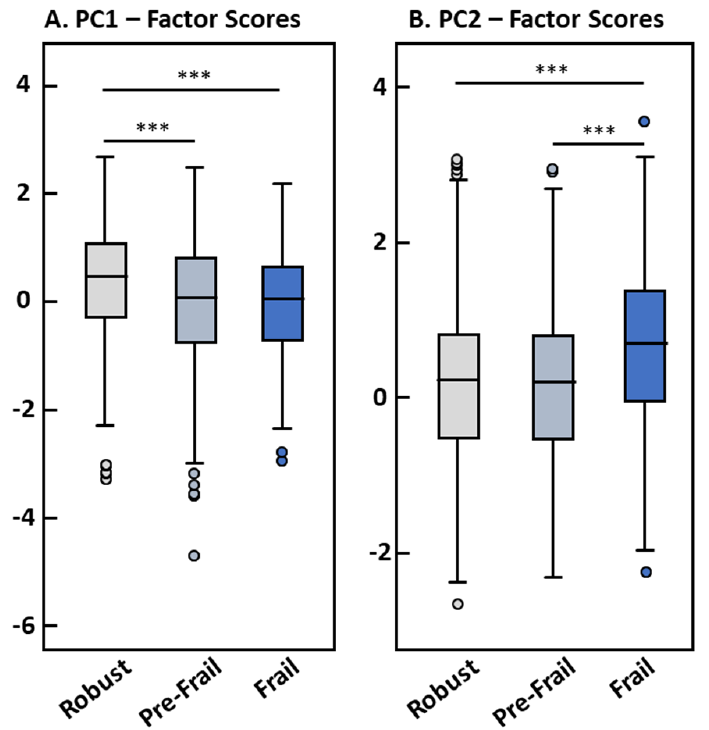
Figure 1. Factor scores of PC1 ( A ) and PC2 ( B ) by frailty status ( n = 1348). Differences between frailty groups were assessed using one-way ANOVA. *** significance level p < 0.001.